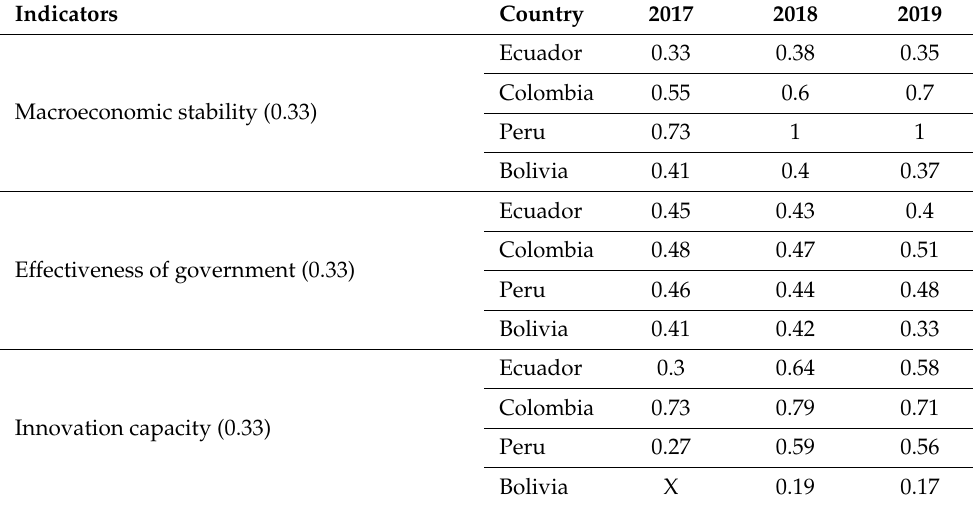
Table 13. The key indicators of country context dimension in the members of the Andean Community (scores). Indicators